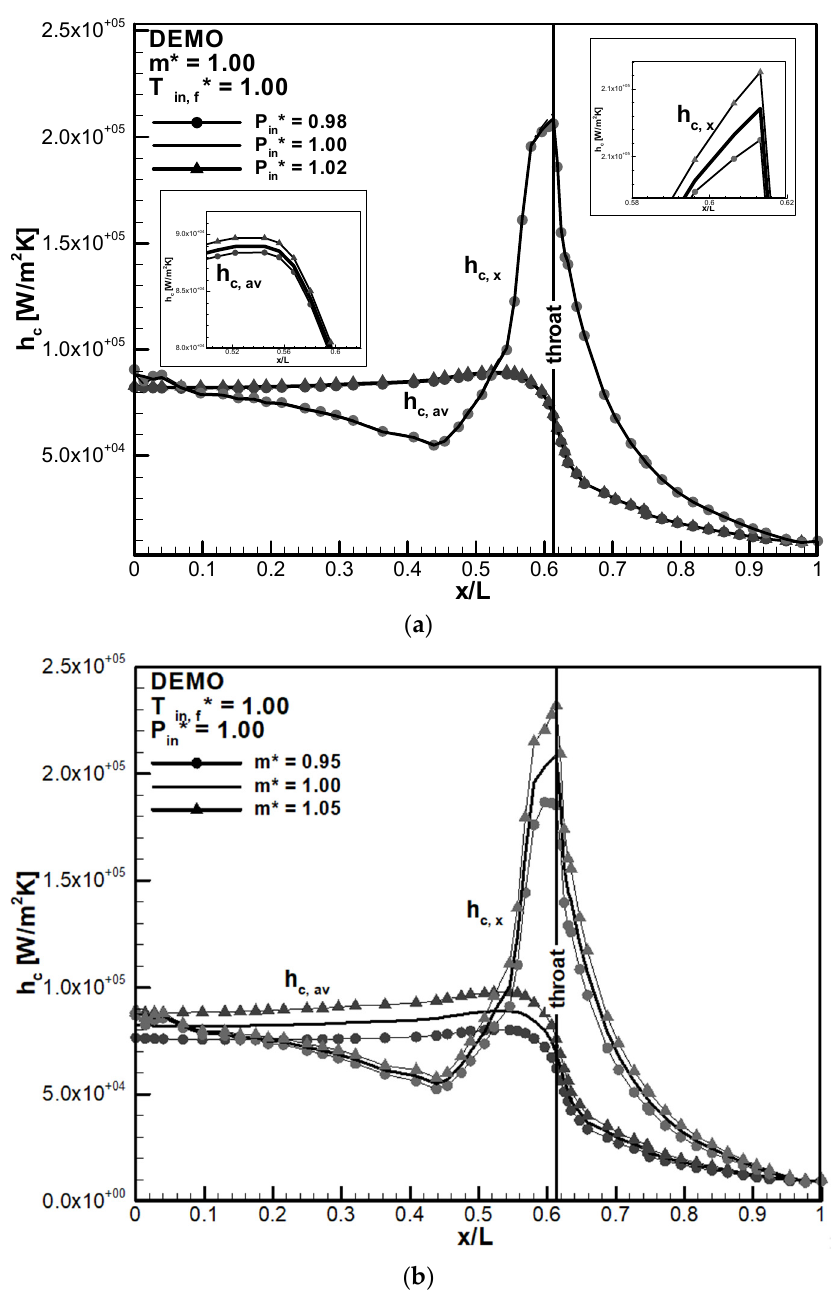
Figure 20. Axial profiles of local and average convective heat-transfer coefficients (runs 1, 5-8): ( a ) effects of inlet pressure; ( b ) effects of mass flow